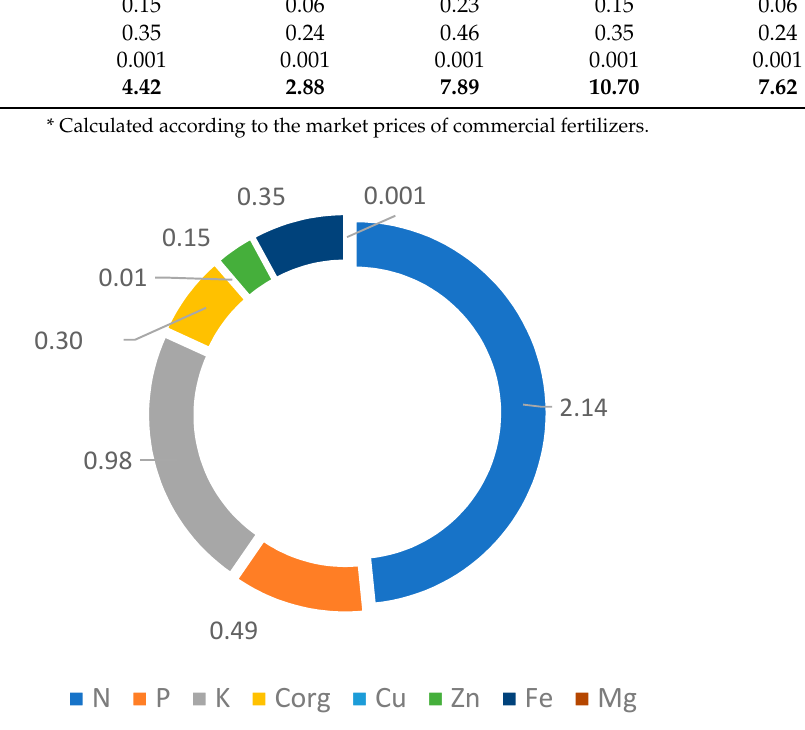
Figure 3. Average value of liquid digestate according to the different elements, EUR t − 1 .